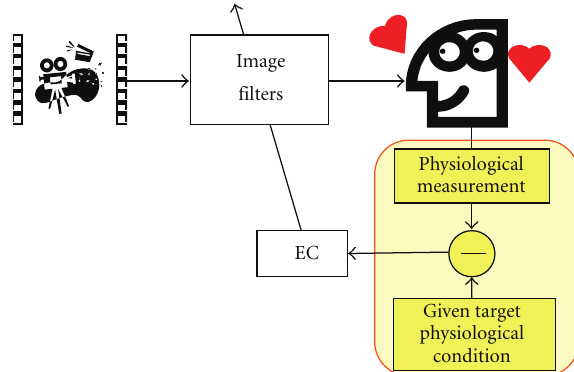
general framework. Filter evolves to bring the measured physio- logical data of an IEC user to the ideal condition of the targeted physiological